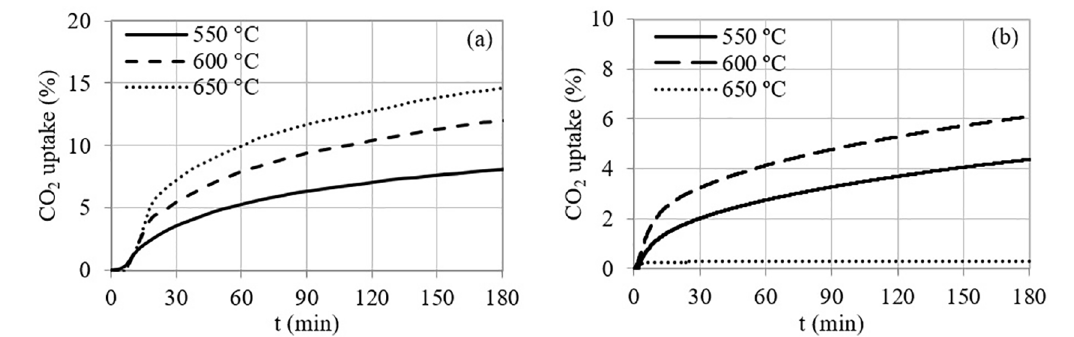
SiO as a function of temperature, for CO 4 4